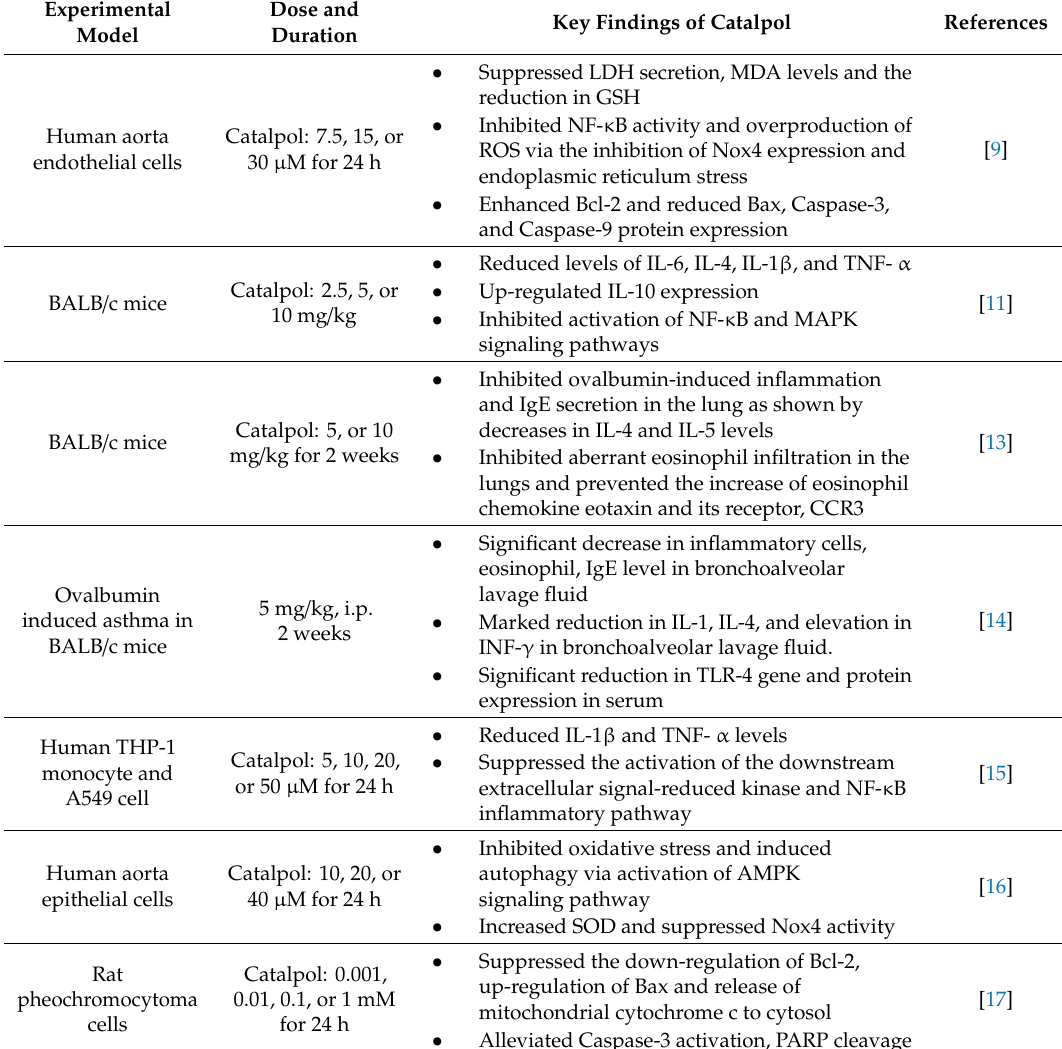
Table 1. E ff ect of catalpol in experimental models of inflammation and oxidative stress.